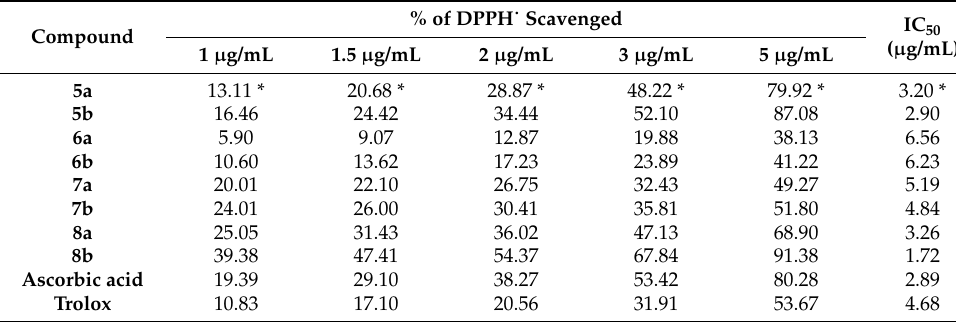
Table 2. Results of the DPPH ˙ scavenging assay.